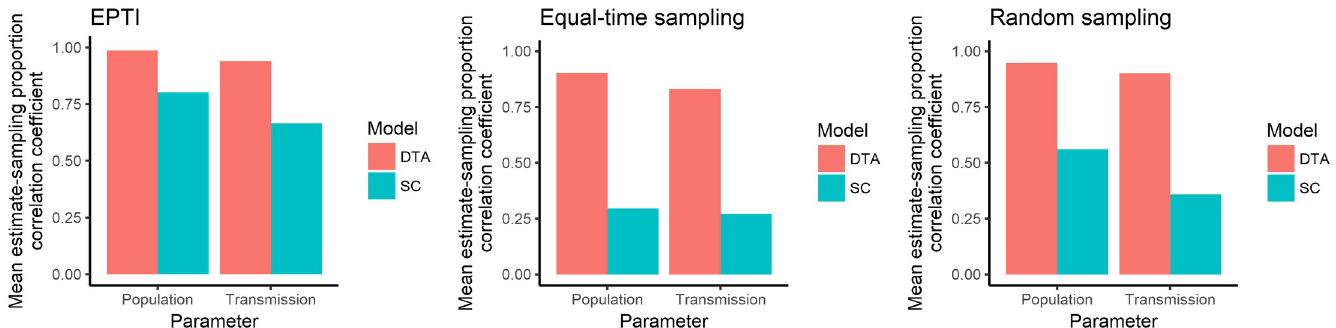
Fig 15. Bar graph of the correlation coefficients between the SC and DTA models’ mean estimates and the proportion of isolates sampled from each host population for 12 EPTI simulated outbreaks that 100 isolates were randomly sampled from, and 23 simulated outbreaks that 100 isolates were sampled randomly and equally over time.